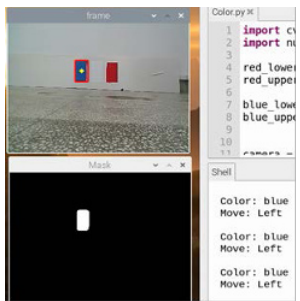
Fig. 9. Item recognition renderings.